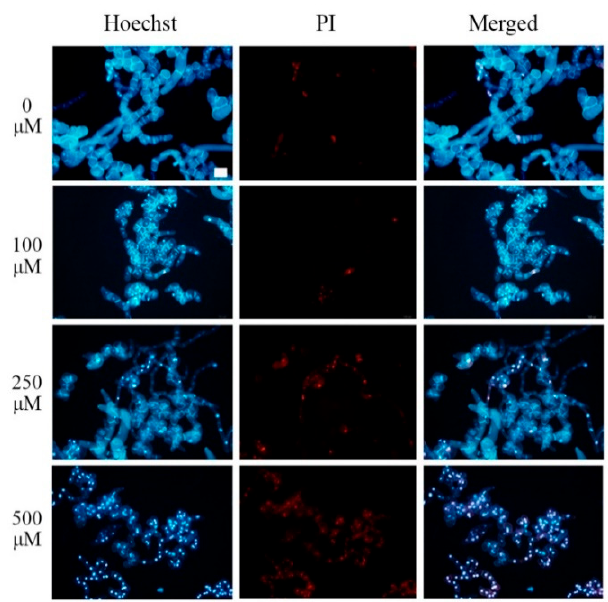
Figure 1. Tobacco BY-2 cells double stained with Hoechst 33342 and propidium iodide (PI). Hoechst 33342 and PI double staining in cultured tobacco BY-2 cells treated with different concentrations (0, 100, 250, and 500 μ M) of Pb(NO 3 ) 2 for 24 h. Scale bar = 100 μ m.